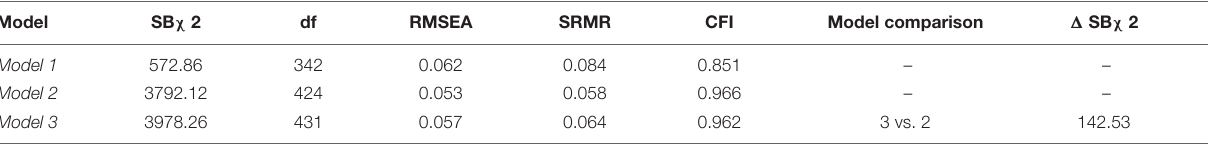
TABLE 4 | Fit indices of the hypothesized and adjusted model for in sample 1 and sample 2. Model